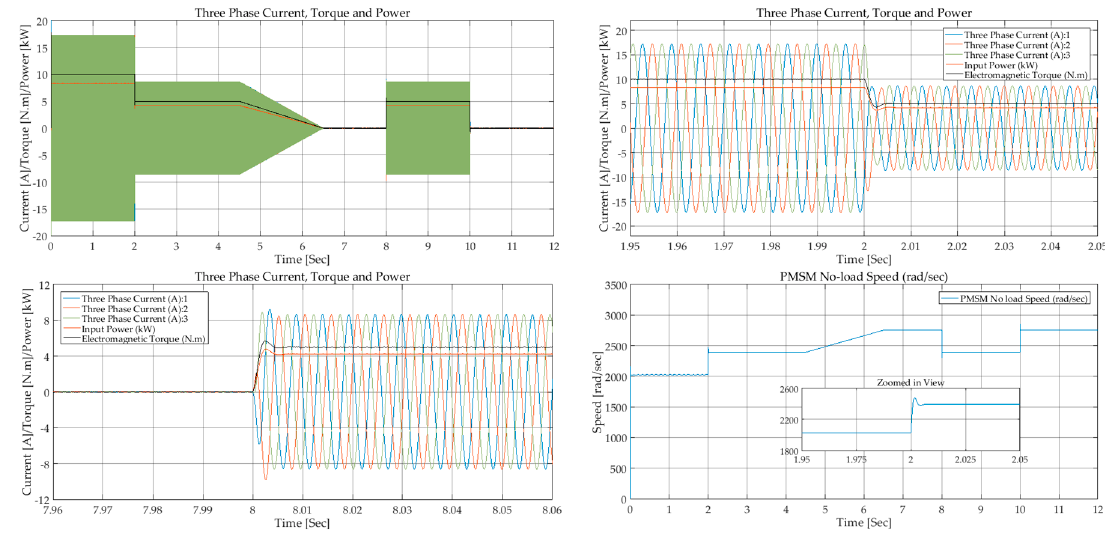
Figure 14. FESS in step-charging mode: Torque, power, and three-phase current (top left, top right, and bottom left); PMSM no load speed (bottom right).